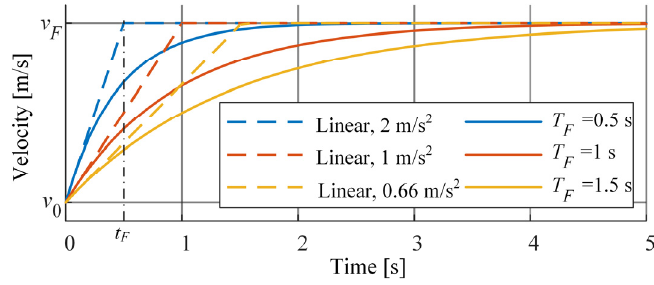
Figure 4. Illustration of nonlinear MPC velocity trajectory.